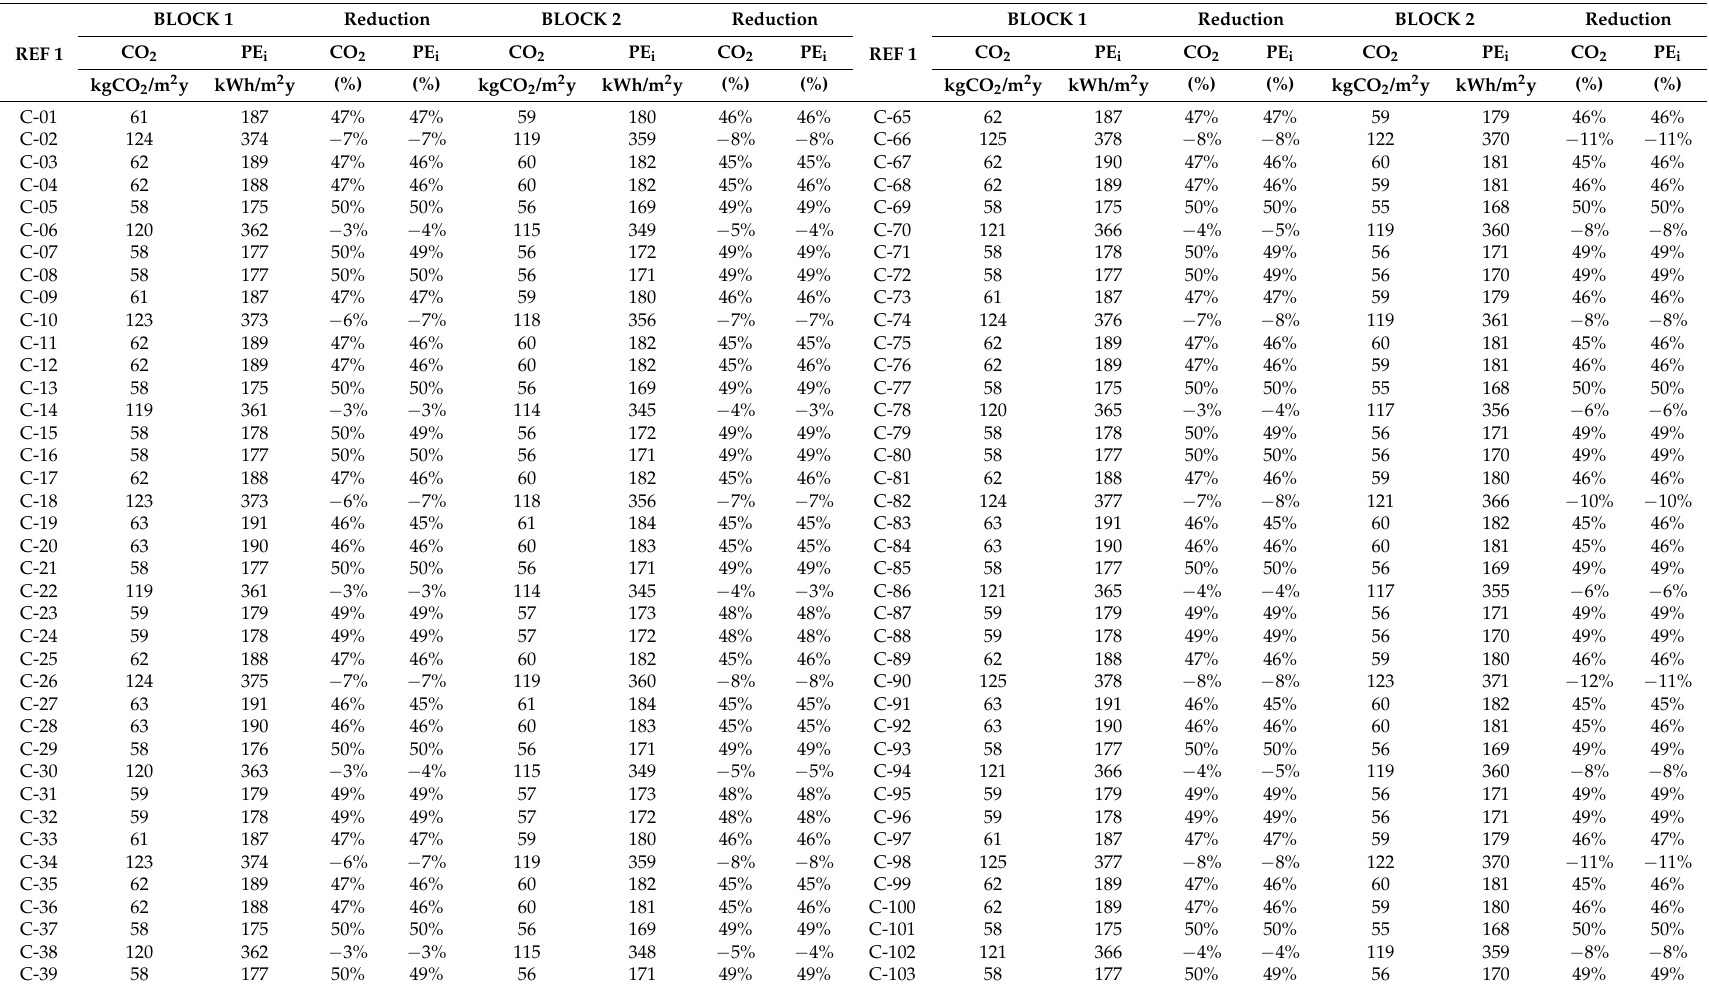
Table 8. Primary energy and CO 2 emissions values for Reference building